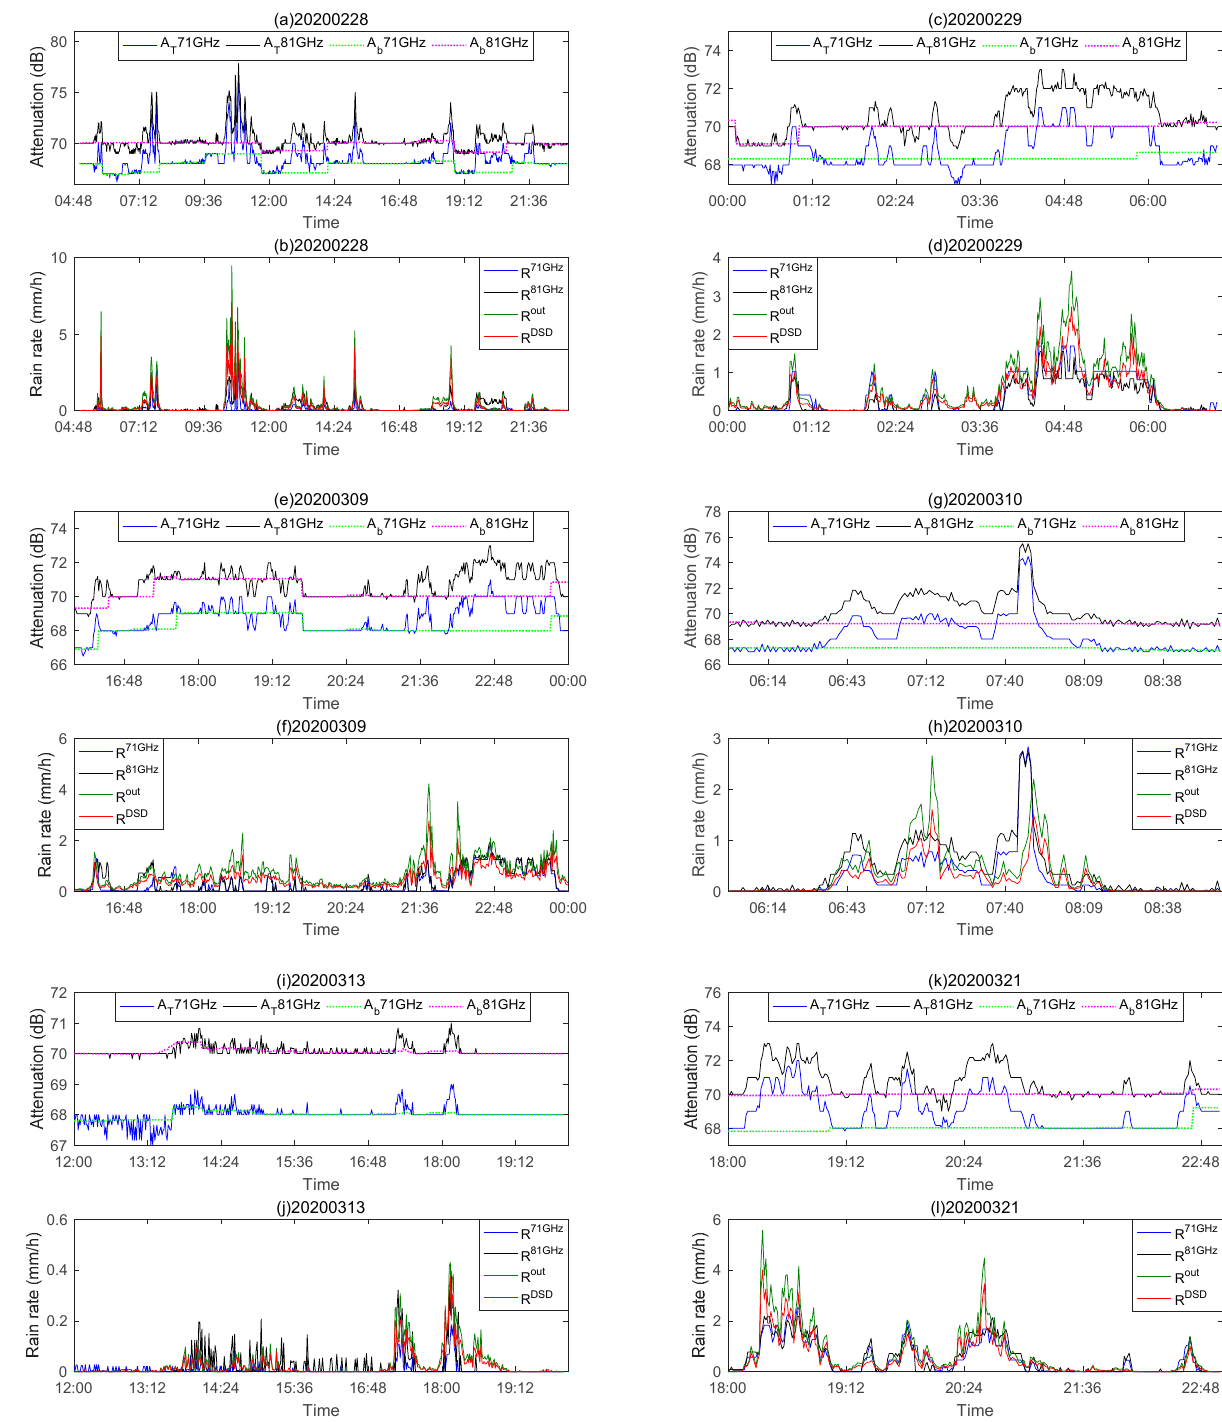
Figure 8. The total attenuation and baseline of 71 and 81 GHz on different days. The comparison result of the link retrieved the rainfall rate R 71 GHz and R 81 GHz , raindrop spectrometer output rainfall rate R out and DSD data to calculate rainfall rate R DSD .